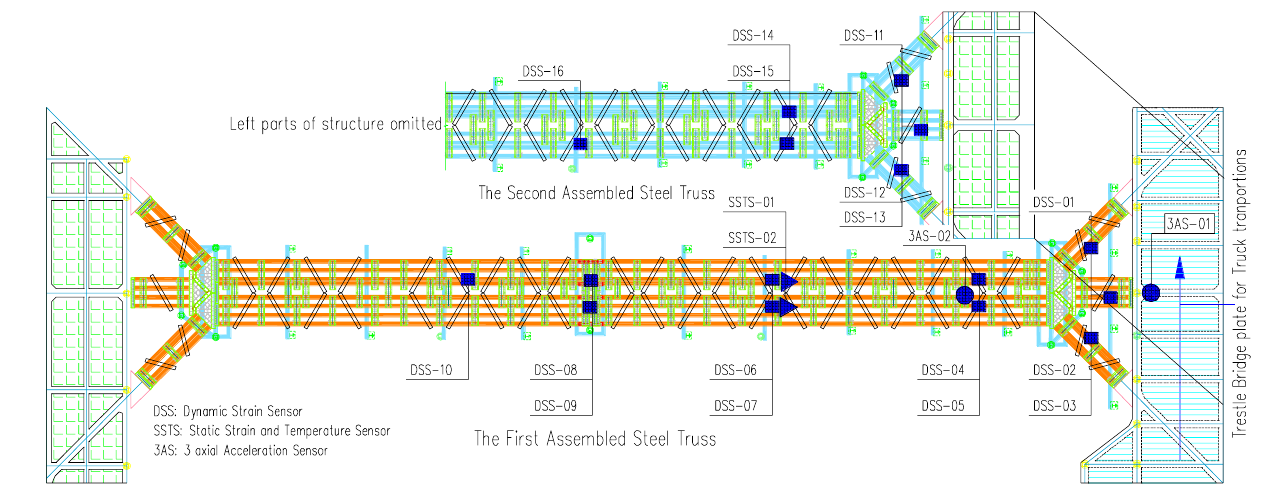
Figure 3. Layout of monitoring points in steel assembly bracing.